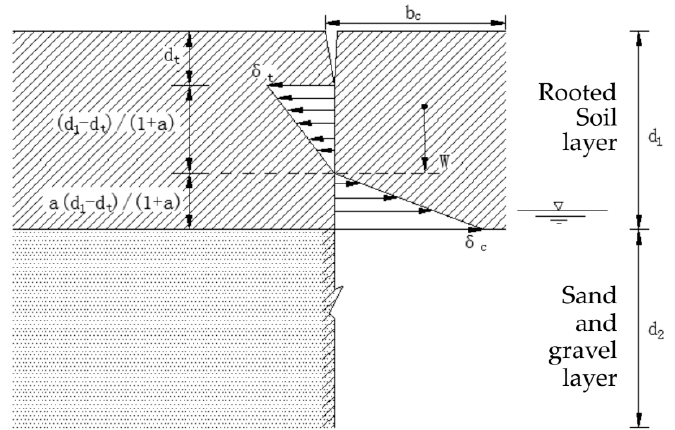
Figure 5. Stress analysis of the upper root-soil layer of a cantilever riverbank (modified from Figure 7 in Xia et al. [44], (not to scale)).